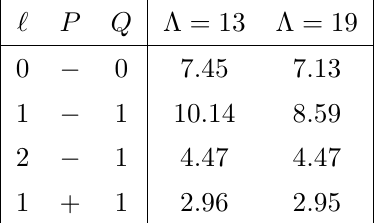
Table 2 . Upper bounds on operators in the O (2)